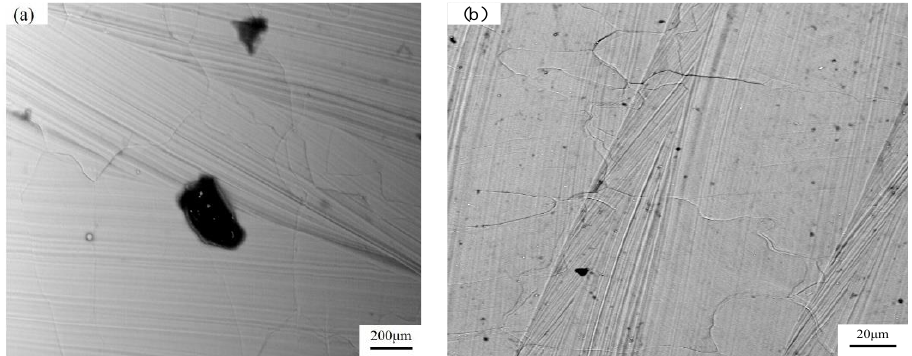
Figure 6. Auxiliary holes and cracks. ( a ) Auxiliary holes; ( b ) Cracks.